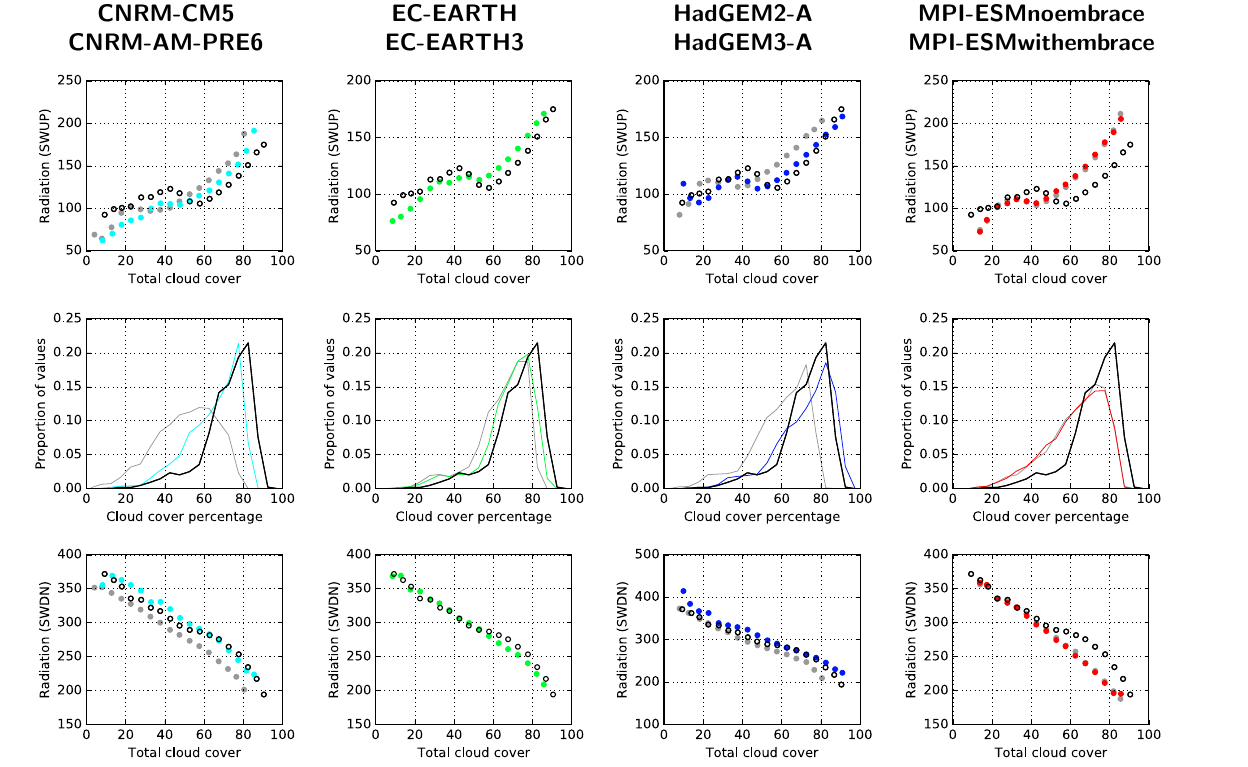
Figure 18. As Fig. 17 but for the northern part of the Southern Ocean region (SOC-N, 30–45 ◦